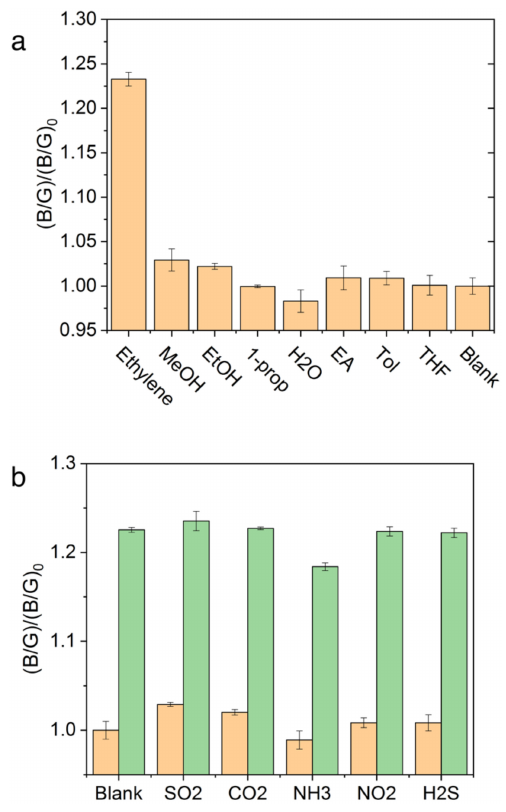
Figure 5. Selectivity and interference of PYG for ethylene in the presence of other ( a ) liquid and ( b ) gaseous species at 100 ppm with (orange bar) and without the addition of ethylene (green